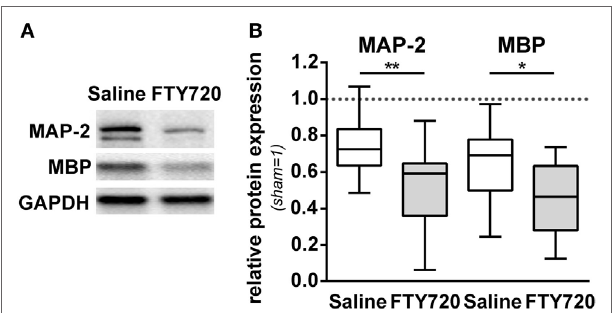
FigUre 3 | HI-induced gray and white matter loss is increased by FTY720 treatment. P9 mice were exposed to HI followed by a single intraperitoneal injection of 1 mg/kg FTY720 or 0.9% NaCl (saline). One week after HI, protein lysates were prepared from ipsilateral hemispheres at the hippocampal level ( − 2.0 to − 2.3 mm from bregma) from brain sections of 200 µm thickness. Following gradient sodiumdodecylsulphate electrophoreses and protein transfer, membranes were incubated with anti-myelin basic protein (MBP), anti-microtubuli associated protein-2 (MAP-2), and anti-glutaraldehyde-3-phosphate dehydrogenase (GAPDH) antibodies (a) . For quantification data were normalized to the reference protein GAPDH and sham controls (B) . HI-induced loss of MAP-2 and MBP was significantly aggravated by FTY720 treatment. n = 14/group, * p < 0.05, ** p < 0.01, unpaired t